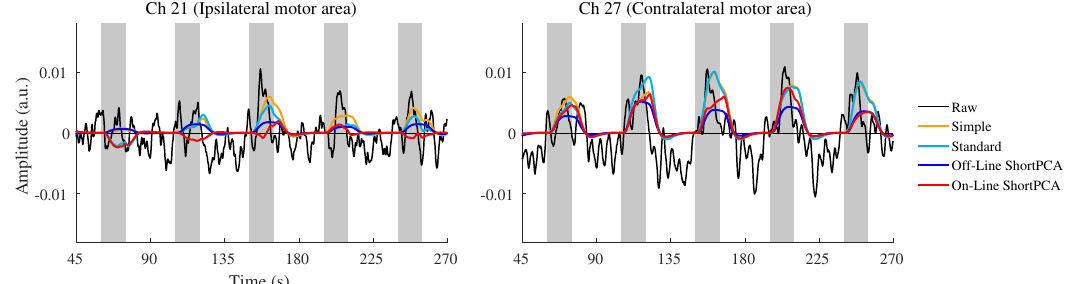
Figure 6. Typical temporal estimated waveforms of cerebral hemodynamics in ipsilateral and contralateral motor area symmetrically located by rt-ShortPCA GLM for real functional near infrared spectroscopy (fNIRS) data of a representative subject during a left-handed finger tapping task. The first trial samples from 0 to 45 s are not shown because of unstable estimated